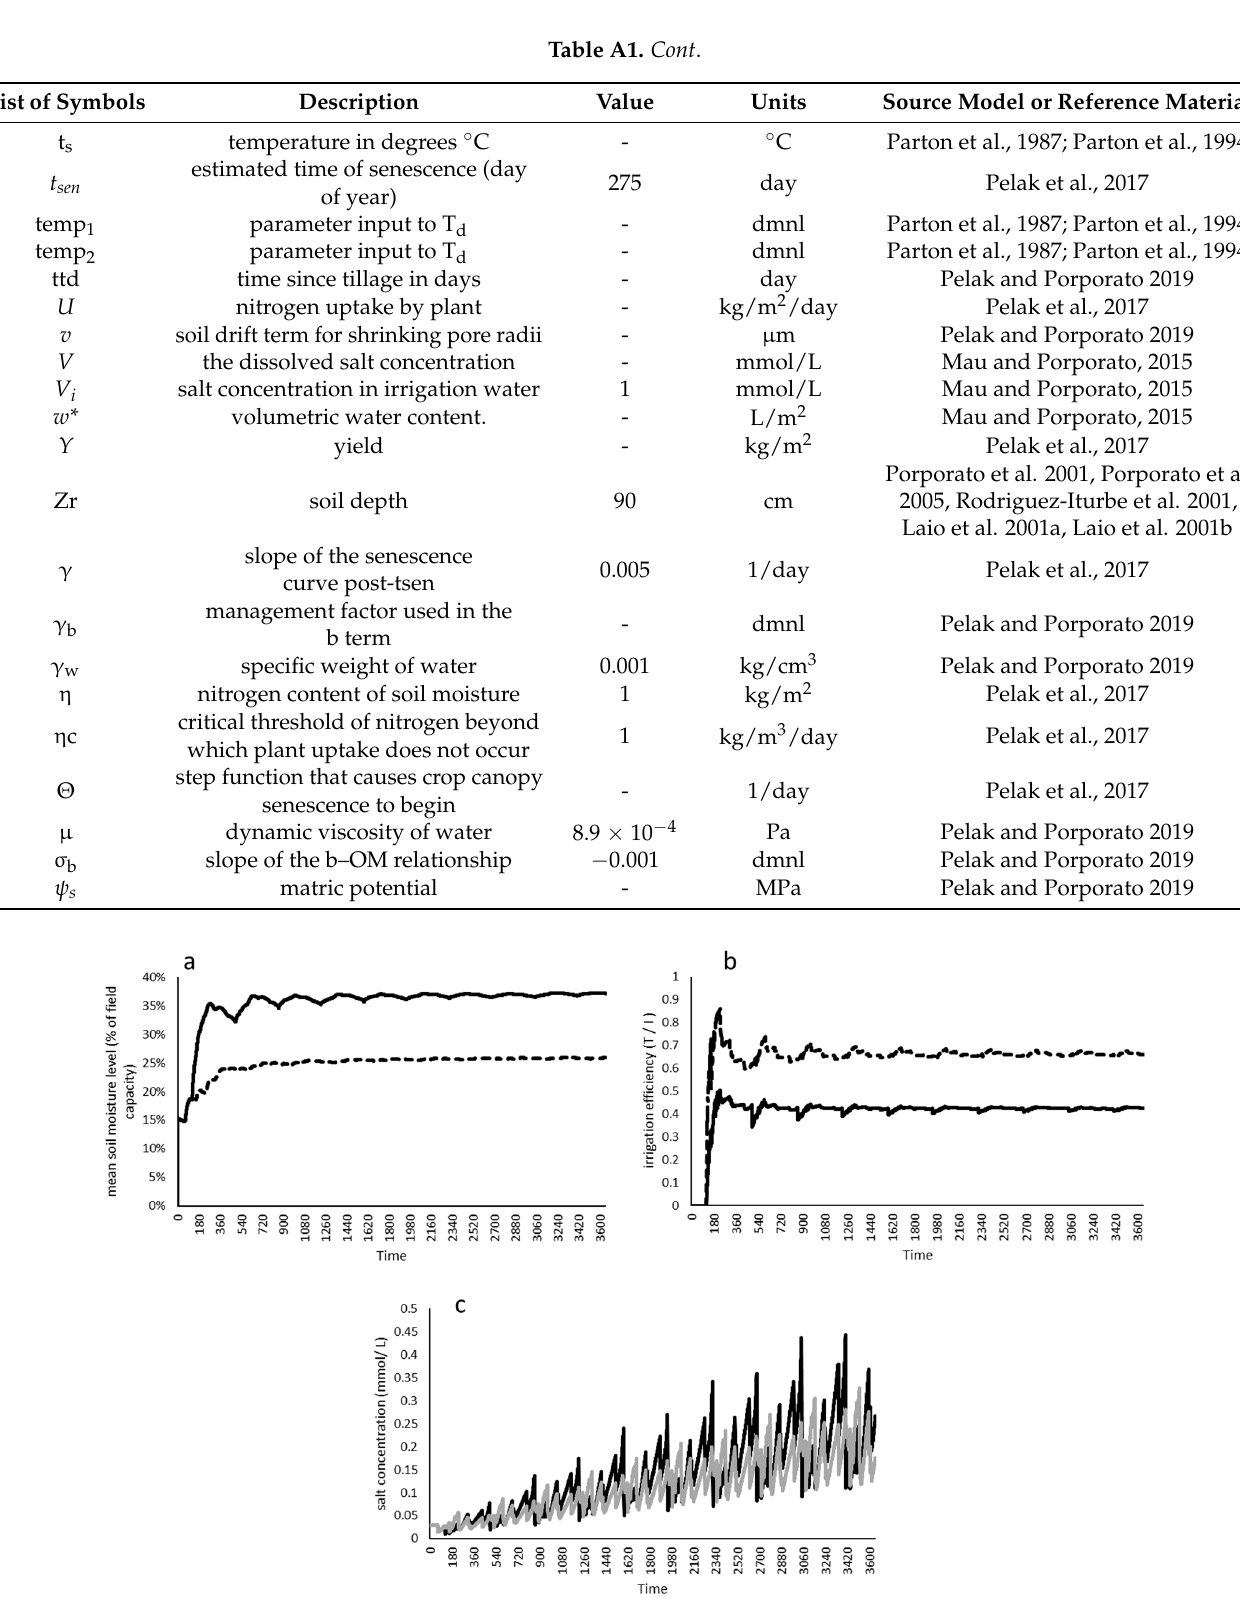
Figure A1. Supplementary biogeochemical results from the irrigation test switch from flood to drip irrigation over 10 years (3650 days): (panel a ) mean soil moisture level under flood (solid line) and drip irrigation (dashed line) methods; (panel b ) irrigation efficiency under flood (solid) and drip irrigation (dashed) methods; and (panel c ) salt concentration in soil water under flood (black line) and drip irrigation (gray line) methods.